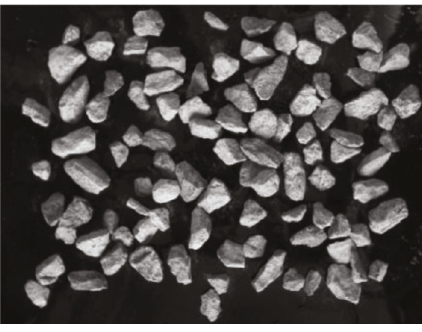
Figure 8: Improved Retinex algorithm to process low-frequency coefficients.